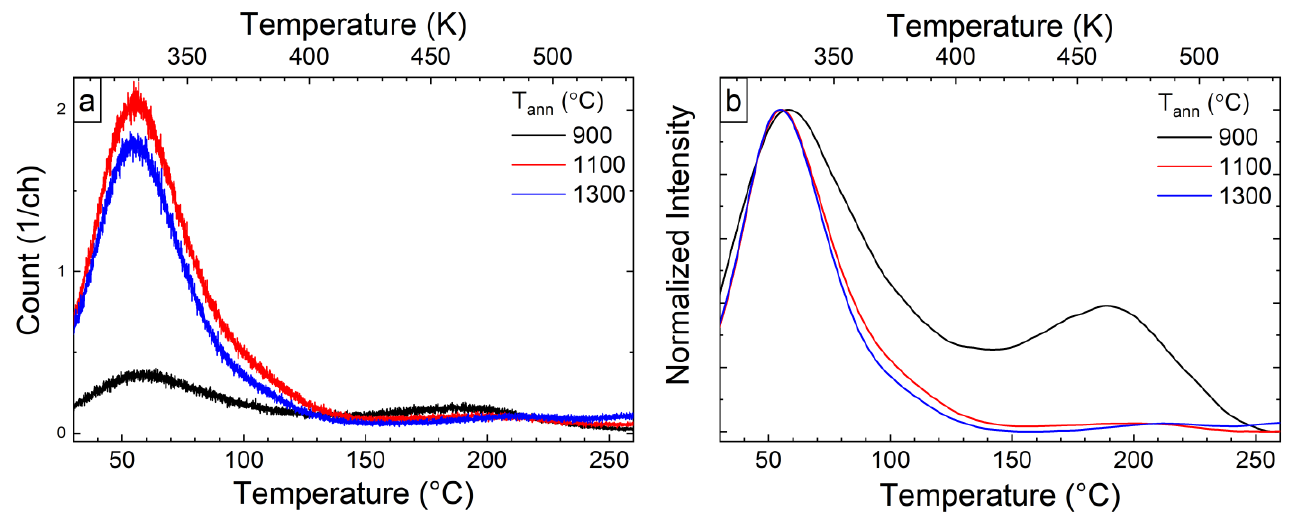
Figure 7. TL glow curves as it is (a) and normalized (b), detected after irradiation with X-rays for 5 min, β– 0.5 °C/s.